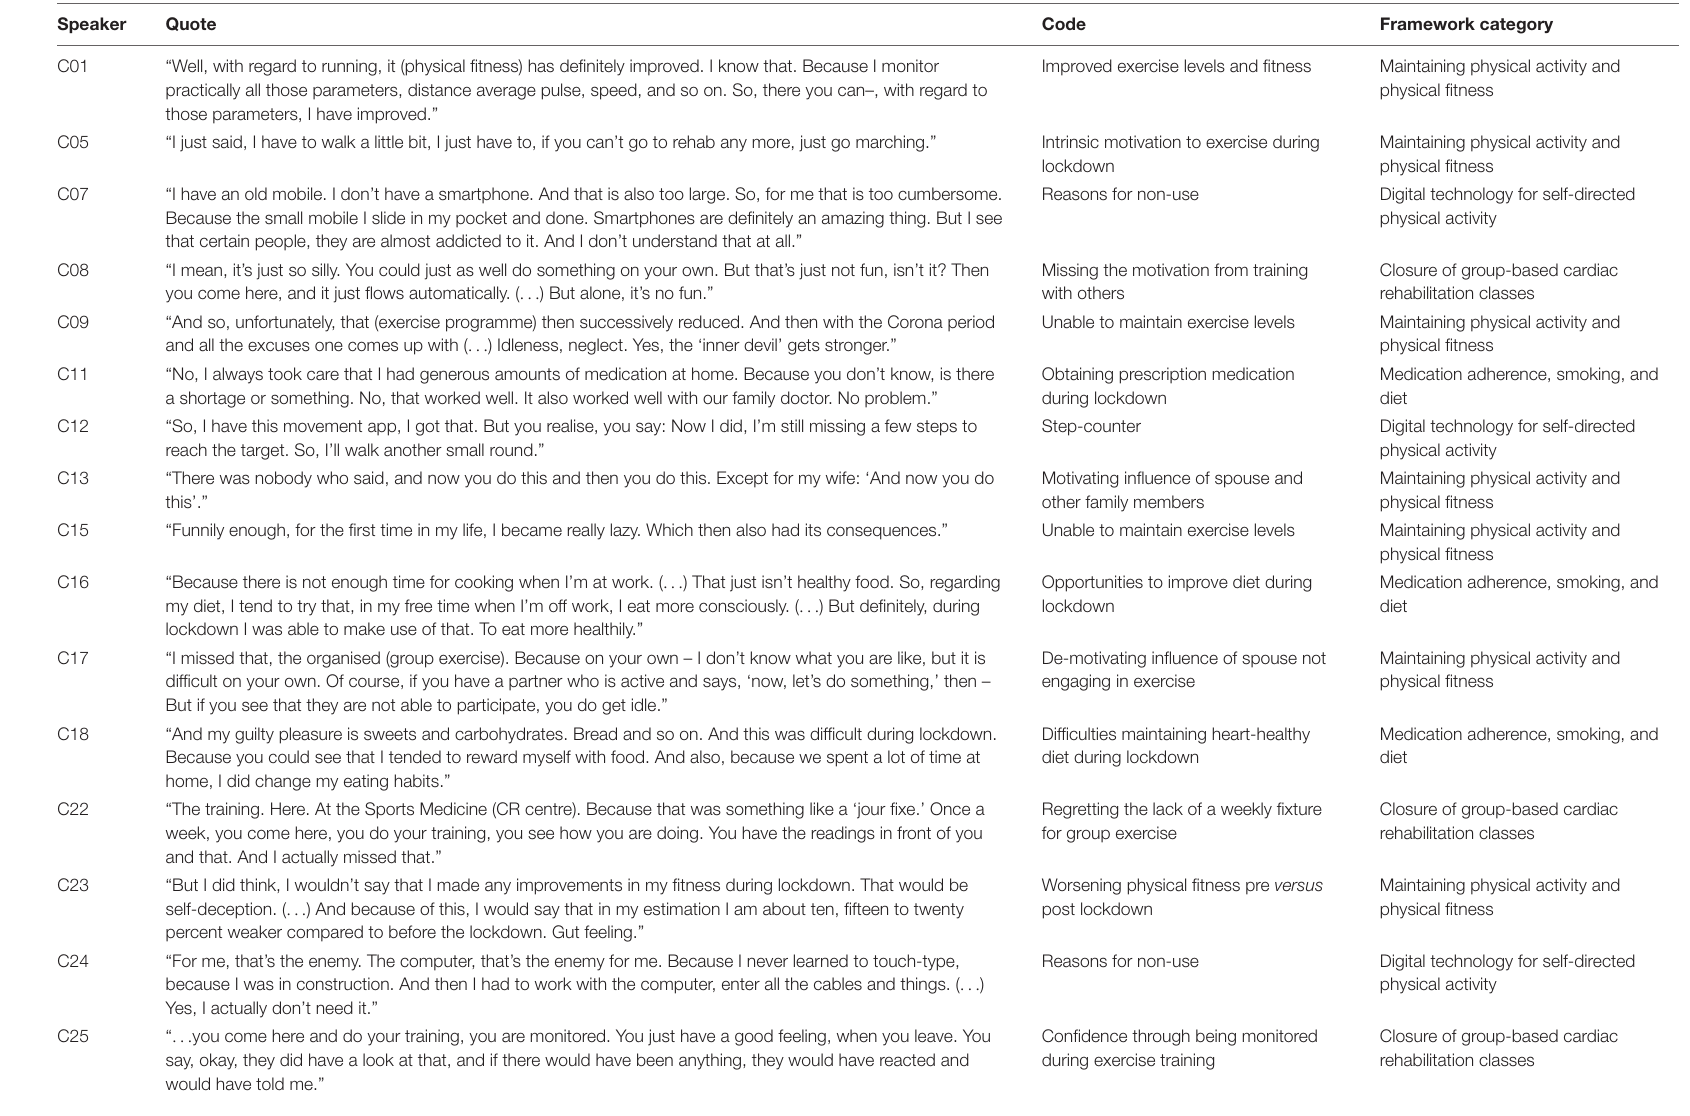
TABLE 3 | Anonymised quotes from qualitative interviews. Speaker